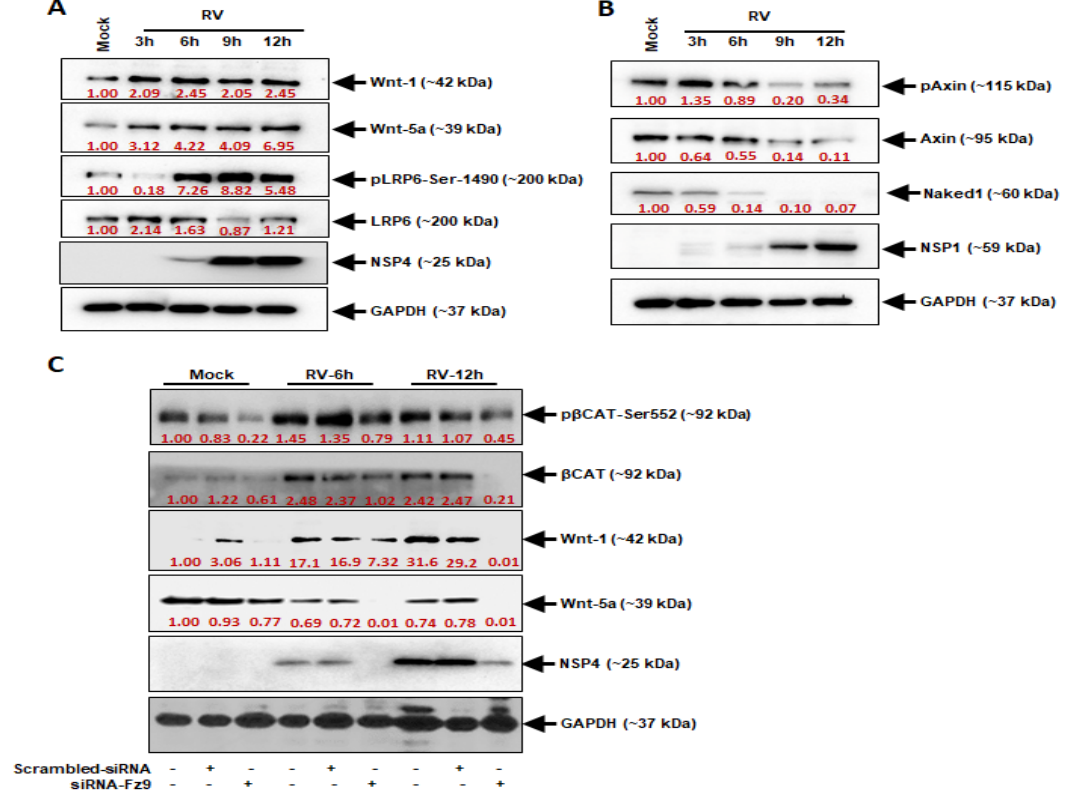
Figure 2. Wnt-1/Wnt-5a pathway activates during RV infection. ( A ) Expression of Wnt-1 and Wnt-5a have been gradually upregulated during RV infection. LRP6 has also been hyper phosphorylated during RV infection; ( B ) Phosphorylation of Axin and its total component have been reduced in RV infected cells. Expression of Nkd1 is suppressed in RV infected cells; ( C ) Phosphorylation of β -catenin Ser552 significantly inhibited in siRNA-FzD9 treated but RV infected cells. The total β -catenin level is also suppressed. The expressions of Wnt-1 and Wnt-5a are also inhibited in siRNA-FzD9 treated but RV infected cells. This may be the result of negative feedback mechanism of Nkd1 or Axin or may be that some other factors are involved in this pathway. The siRNA-FzD9 restricted the RV infection too, as evident by RV-NSP4